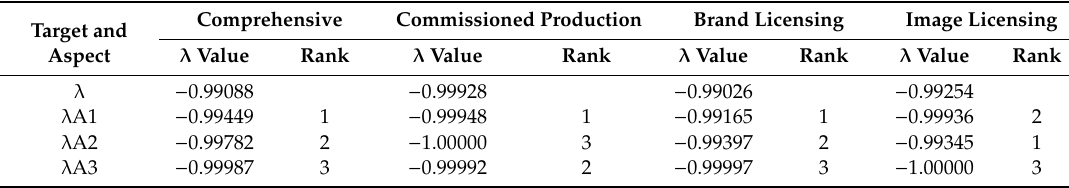
Table 5. λ values of the target and aspect corresponded for each group.